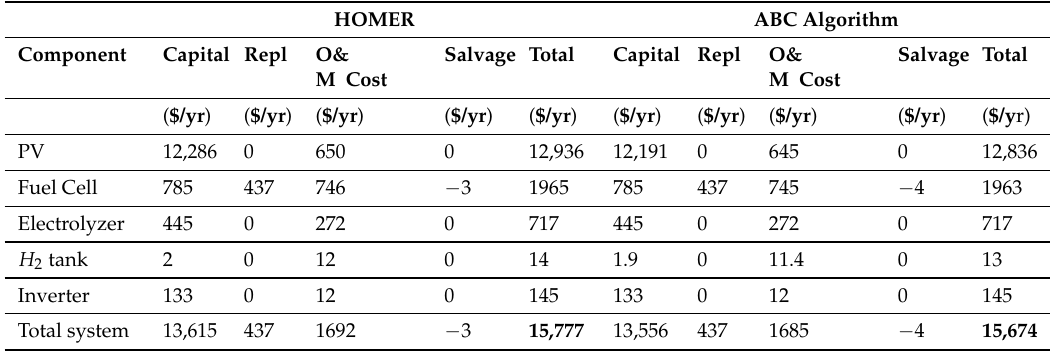
Table 3. Annualized cost analysis obtained by the HOMER and ABC algorithms.